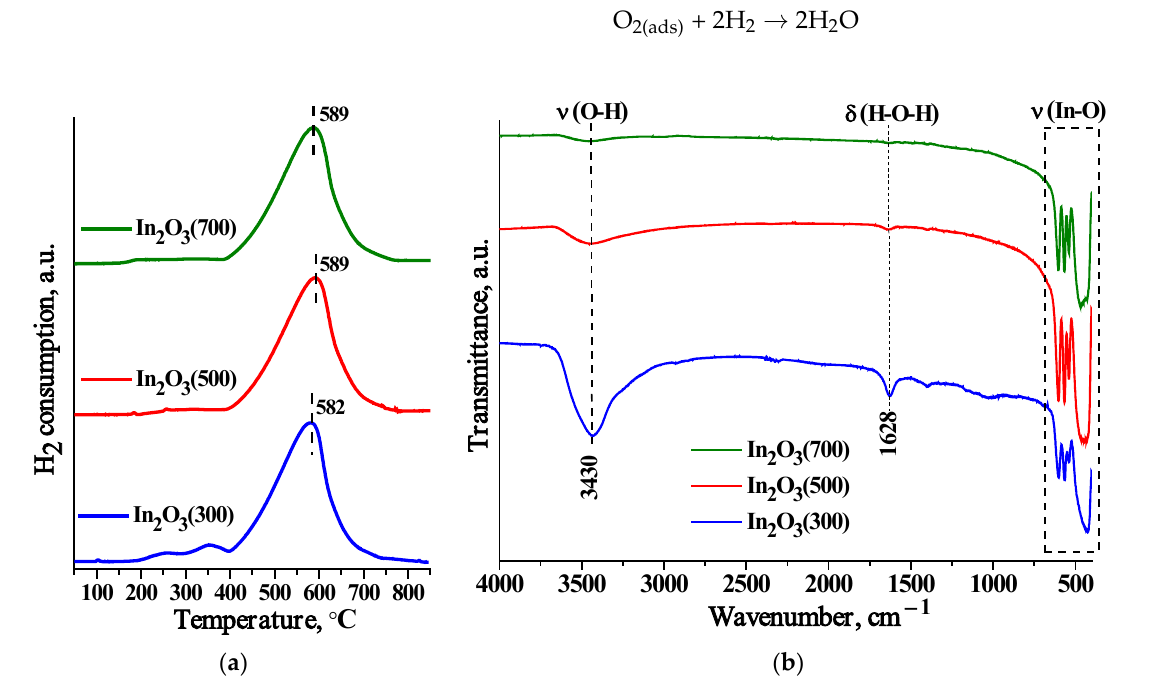
Figure 3. TPR-H 2 curves ( a ) and FTIR spectra ( b ) of nanocrystalline In 2 O 3 samples with different annealing temperatures. Table 3. The results of the TPR-H 2 experiments.